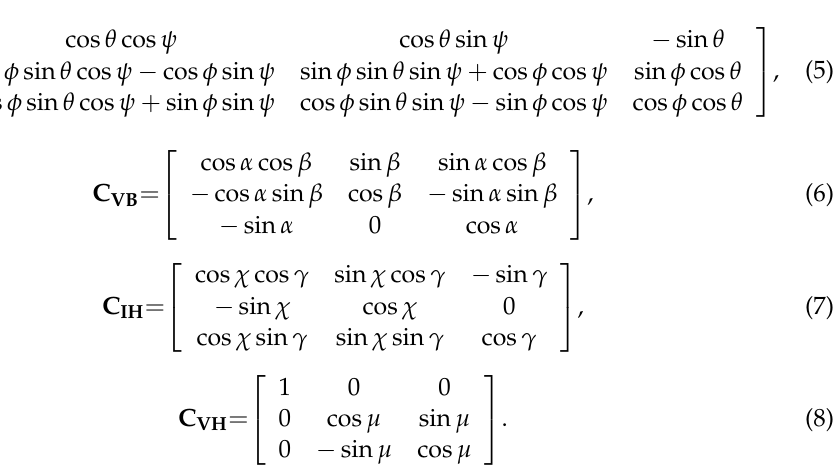
Figure 8. The coordinate transformations between F H , F V , F I , and F B . u can be the position vector, velocity vector, or angular velocity vector of an arbi- trary point, C BI , C HI , C VB , and C HV are rotation matrices [29], and their expressions are given